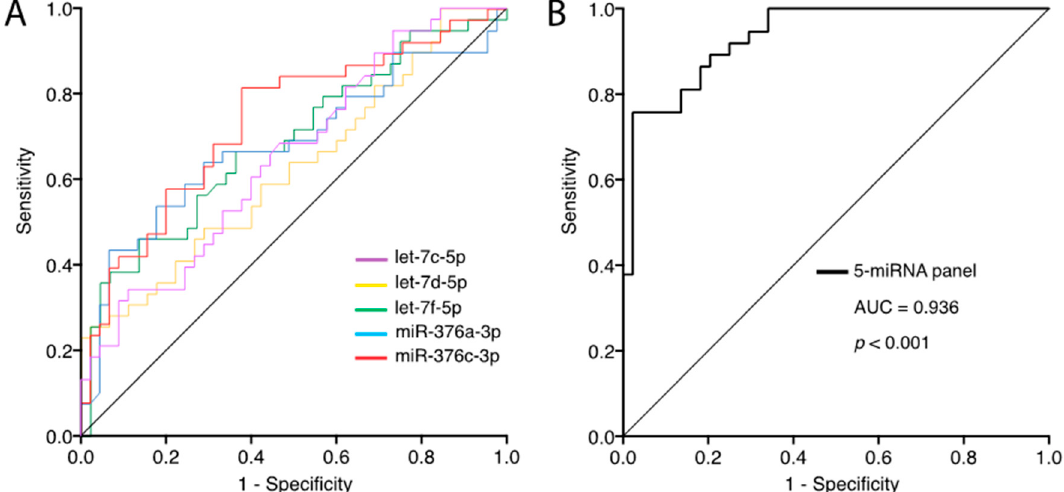
5-miRNA panel (let-7c-5p, let-7d-5p, let-7f-5p, miR-376a-3p and miR-376c-3p) as biomarkers to cat- egorize statin intolerant patients. AUC: area under the curve; CI: confidence interval; miRNA: mi- croRNA.